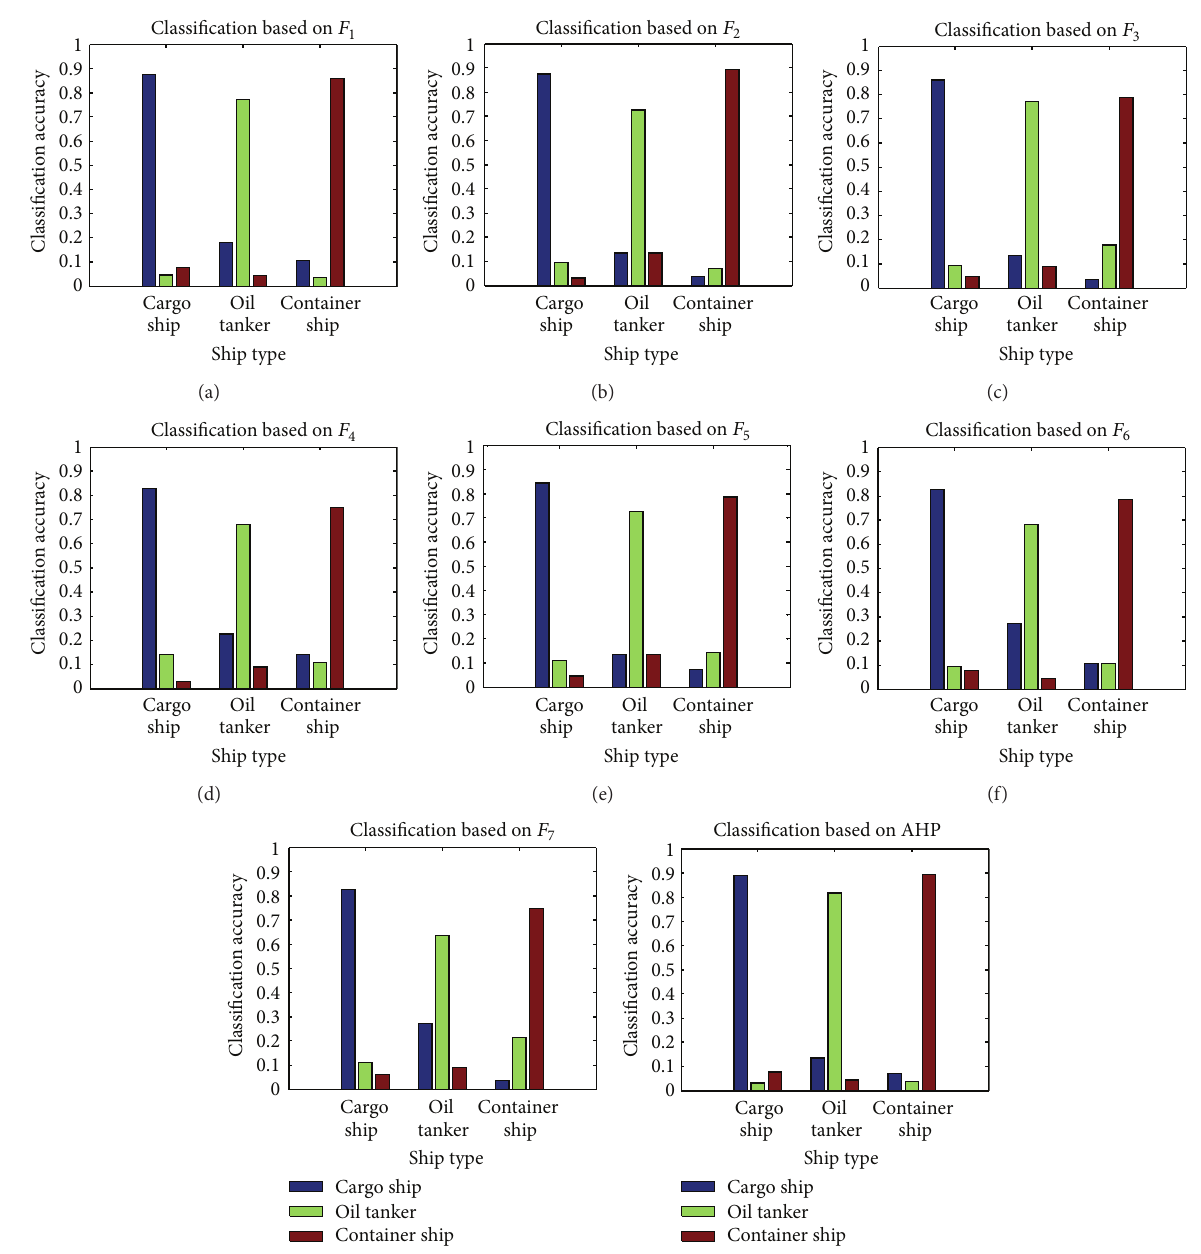
Figure 8: Diagram of confusion matrix: (a) 𝐹 1 , (b) 𝐹 2 , (c) 𝐹 3 , (d) 𝐹 4 , (e) 𝐹 5 , (f) 𝐹 6 , (g) 𝐹 7 , and (h)